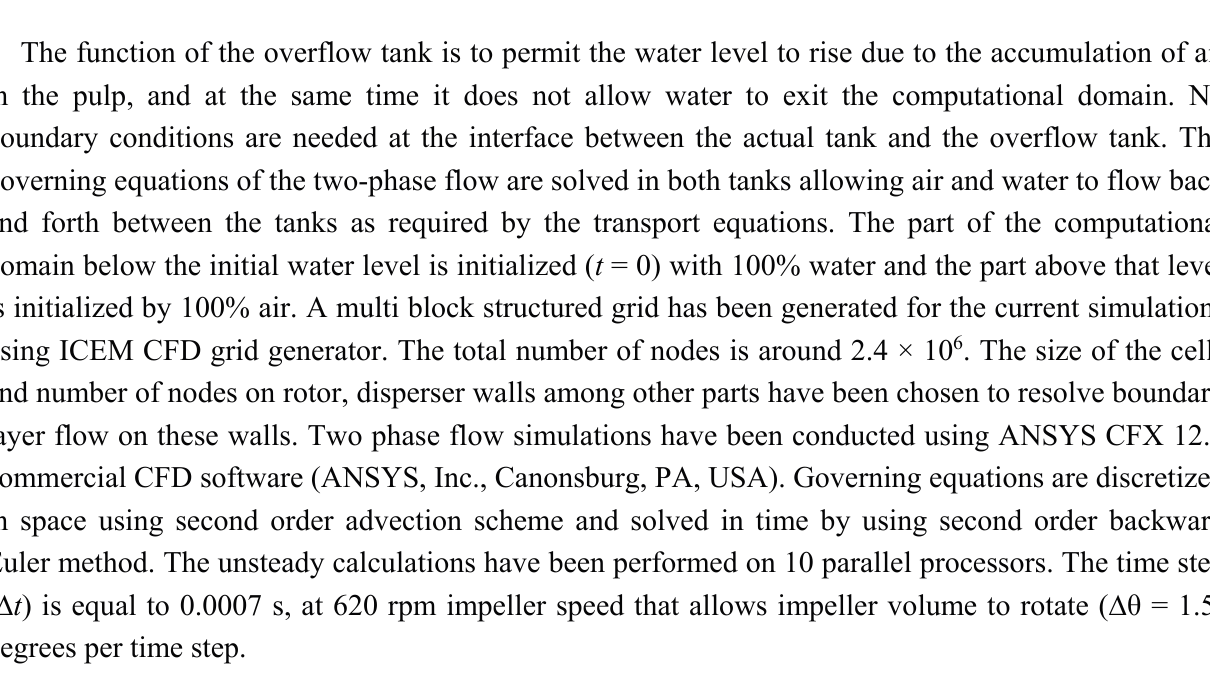
Figure 3. Wemco-0.8 m 3 assembly: tank, air-inlet and initial water